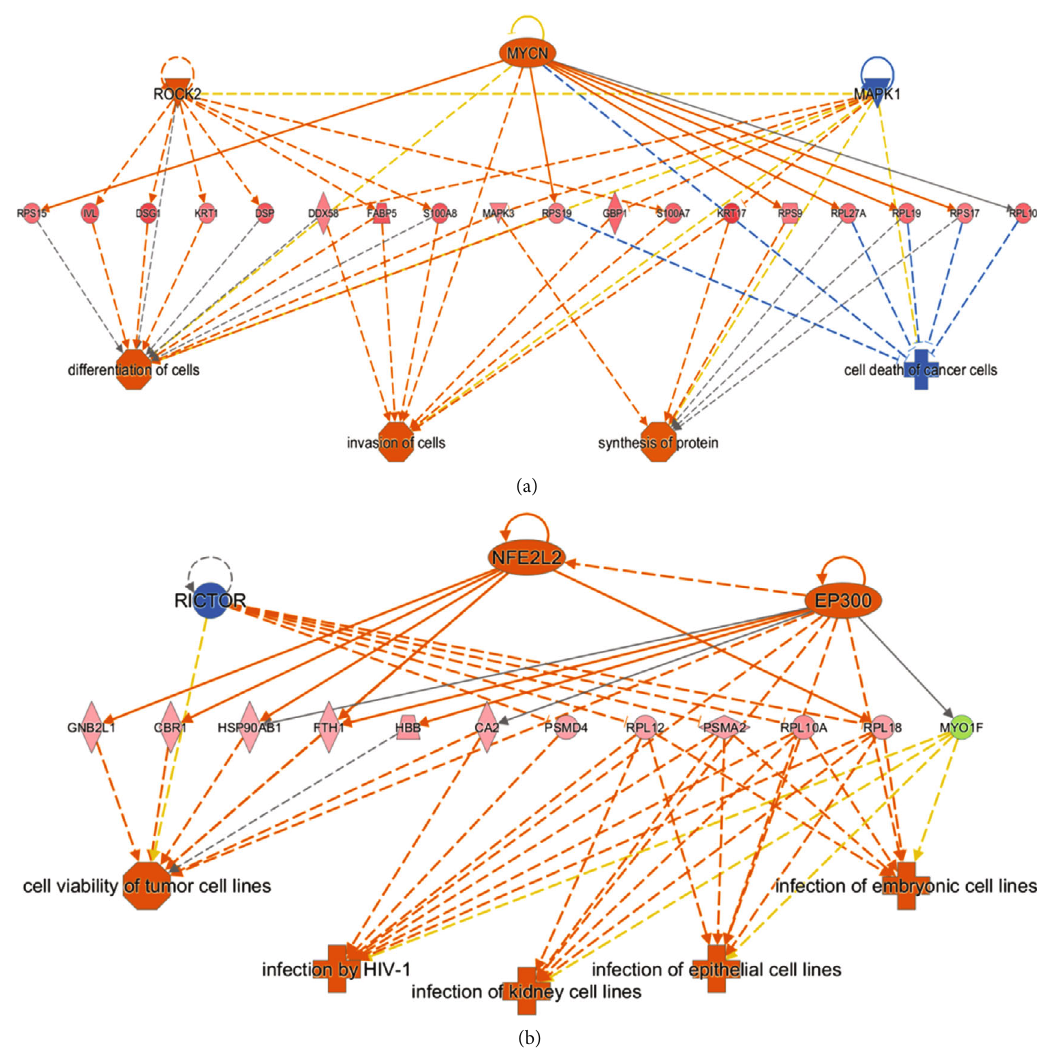
Figure 7: The interaction network and downstream function of upstream regulators. (a) Regulators derived from di ff erential proteins in C/B group. (b) Regulators derived from di ff erential proteins in D/B